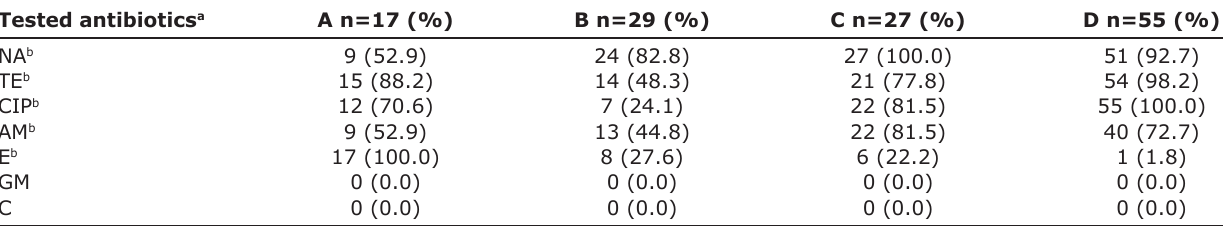
and neck skins for each tested antibiotic Table-4: Antimicrobial resistance rates of thermophilic Campylobacter strains according to the visited slaughterhouses. Tested antibiotics